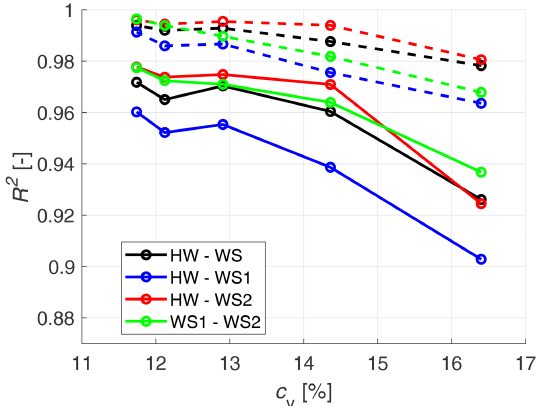
Figure 17. Correlation between WindScanner and hot-wire time se- ries, as a function of coefficient of variation, for both 451.7Hz (solid lines) and 1Hz (dashed lines) resolution. HW denotes the hot wire, WS1 and WS2 stand for WindScanner 1 and 2, respectively, and WS resembles the dual-Doppler reconstruction.